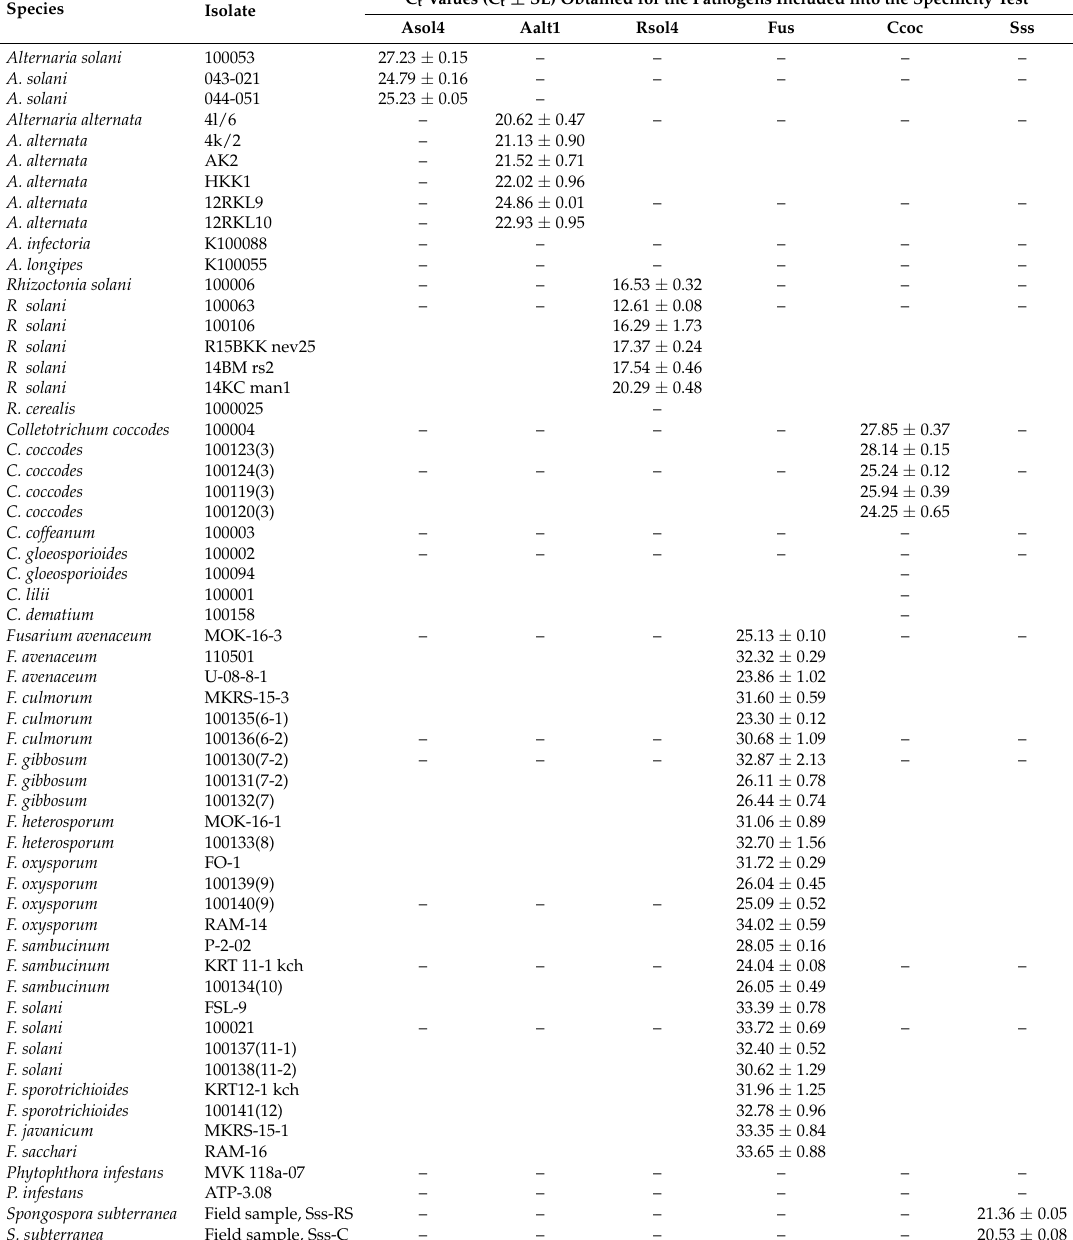
Table 3. Specificity test for individual DNA-based systems for diagnostics of fungal pathogens of potato.